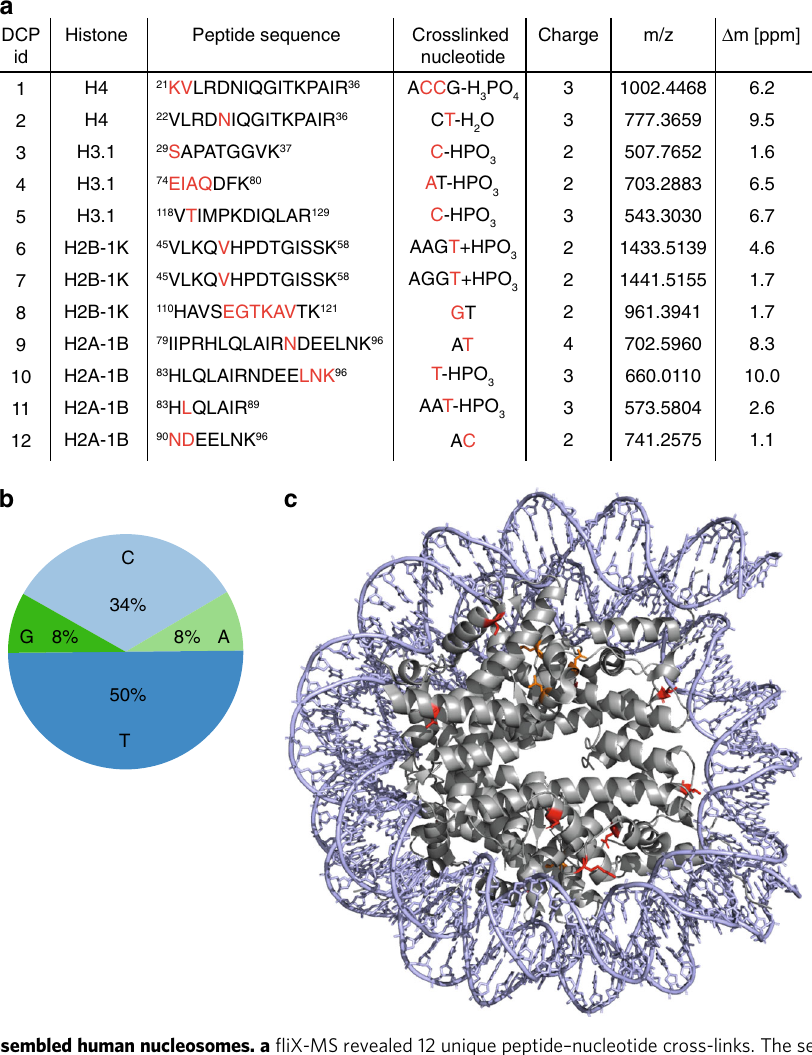
Fig. 3 fl iX-MS of in vitro assembled human nucleosomes. a fl iX-MS revealed 12 unique peptide – nucleotide cross-links. The sequences of the cross-linked peptides are shown. For cross-links that could be located on one or several amino acids, the location within the peptide is marked in red letters. The cross- linked nucleotide sequence derived from precursor mass differences (A: deoxyadenosine, C: deoxycytidine, G: deoxyguanosine, T: thymidine), charge state, mass-to-charge ratio ( m / z ), and mass error ( Δ m ) are shown. The cross-linked base is marked in red letters. b Base distribution among cross-links. c Crystal structure of the human recombinant nucleosome (PDB ID: 2CV5 8 ), with cross-linked amino acids marked in red (close to DNA) and orange (distant to DNA). For cross-links with more than one potential cross-linked amino acid, the residue closest to the DNA